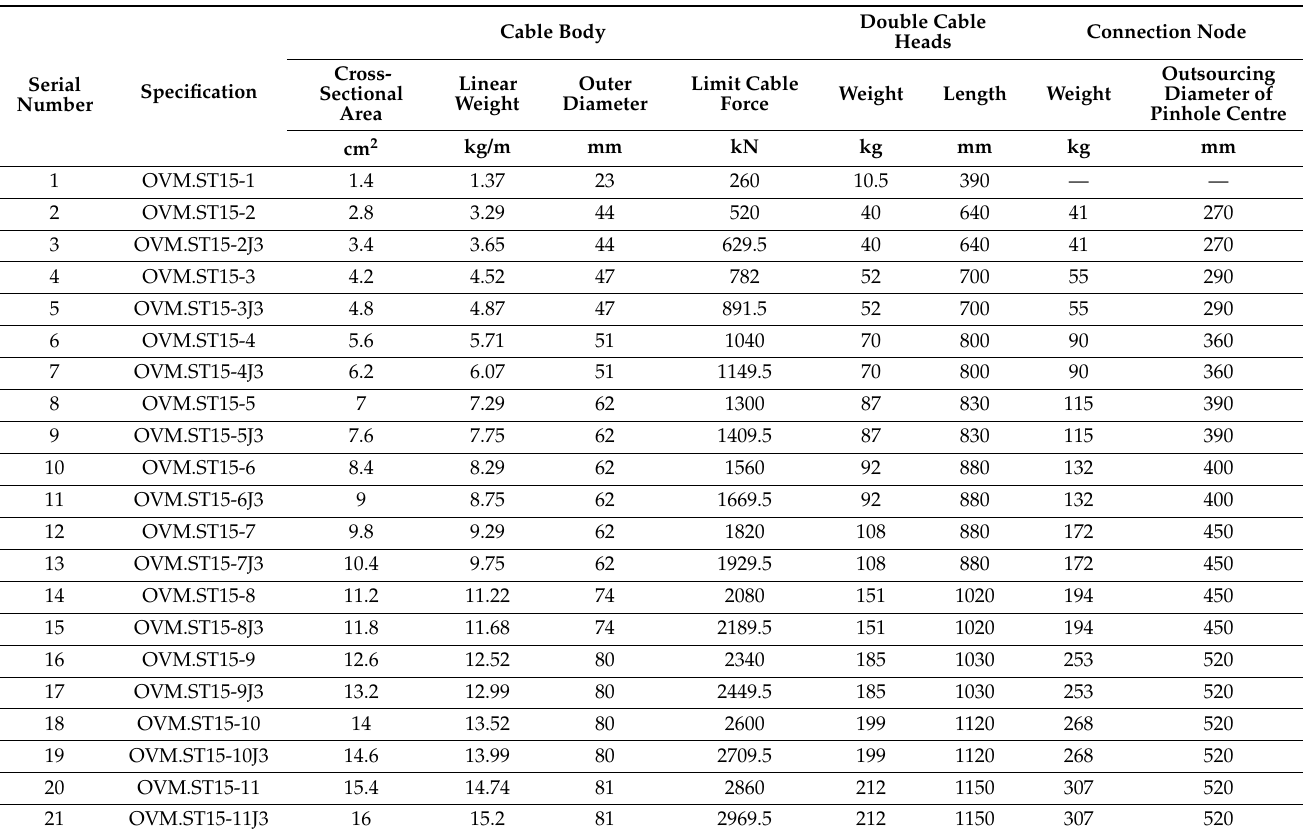
Table 1. Parameters of OVM.ST cable and connection